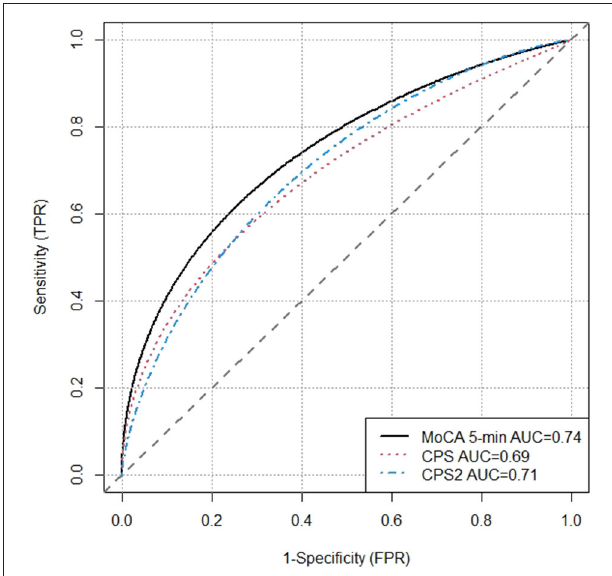
FIGURE 1 | Receiver operating characteristic (ROC) curves for CPS, CPS2, and MoCA 5-min.